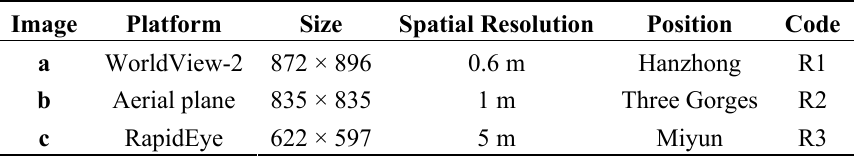
Figure 1. Images of test data. ( a ) A WorldView-2 image; ( b ) An aerial image; ( c ) A RapidEye image. The specific parameters of these images are listed in Table 1. Table 1. Specific parameters of the test